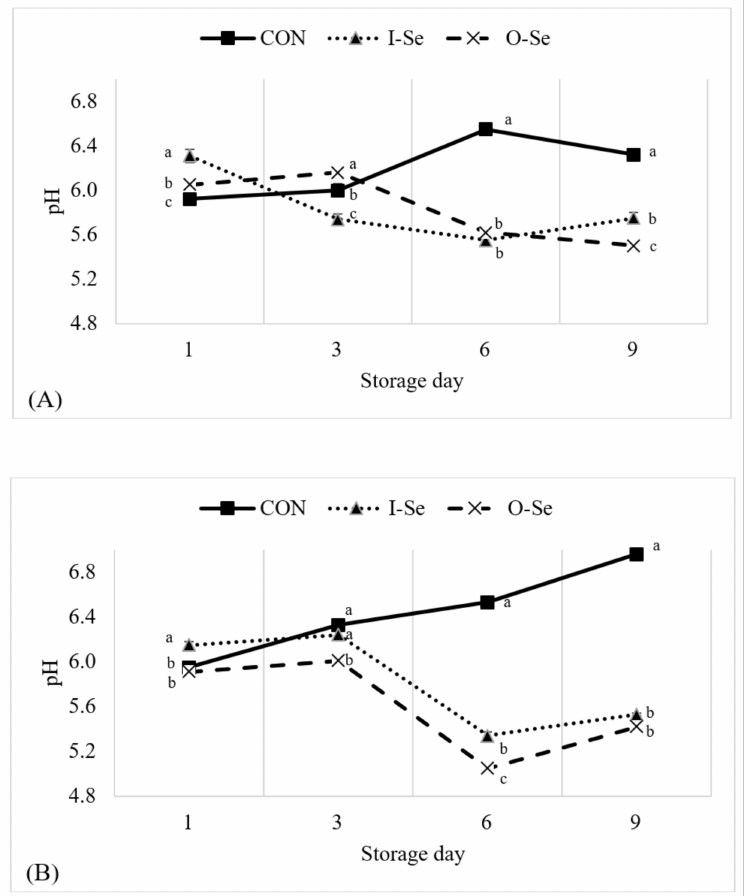
Figure 1. Effects of dietary supplementation with inorganic or organic selenium on the pH for goose meat (equal portions of the breast and thigh meat) ( A ) and liver ( B ) during 9 days of storage at 4 ◦ C. Treatments were defined as CON: basal diet without supplemental selenium; I-Se: basal diet with 0.3 mg/kg inorganic selenium; O-Se: basal diet with 0.3 mg/kg organic selenium. Means within the same day with differing letters are different ( p <